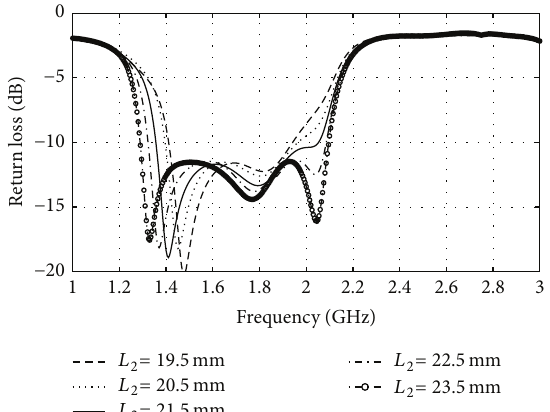
Figure 8: Effect of parasitic strip height on DRA impedance bandwidth (Case II, as mentioned in Table 1), with 𝑎 = 32 mm, = 30 mm, 𝑊 = 5.3 mm, 𝑏 = 29.6 mm, 𝑑 = 48.85 mm, 𝐿 1 1 = 1.5 mm, and 𝑀 = 20 mm and 𝑀 = 45 mm, 𝑇 = 2.95 mm, 𝑊 2 1 2 = 44.26 mm, 𝑠 = 1.575 mm, 𝑃 = 5 mm, and 𝐿 = 𝑊 = 𝑑 𝑑 sma th 130 mm.